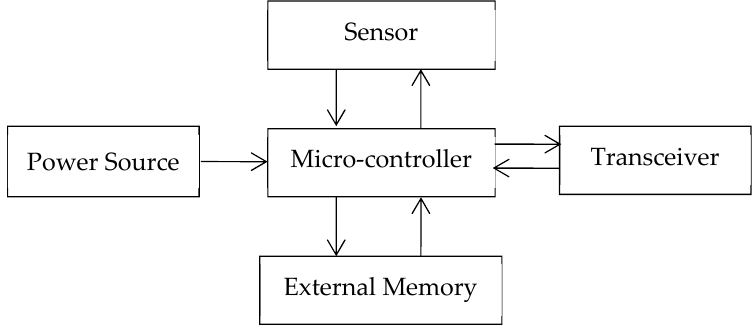
Figure 1. The interconnection of basic components of a wireless sensor.